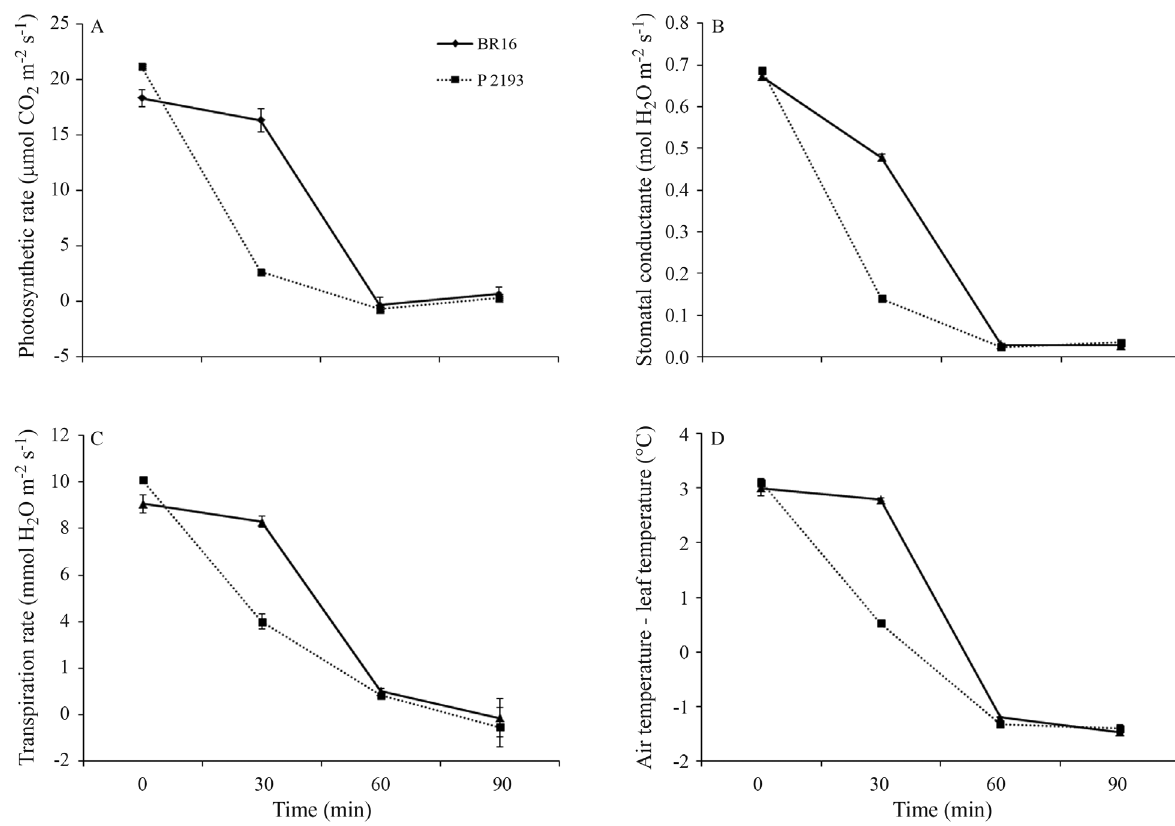
Figure 6 - Physiological responses in control plants (cultivar BR 16) and transgenic P2193 plants during stress for 30, 60 and 90 min. (A) Photosynthetic rate, (B) Stomatal conductance, (C) Transpiration rate and (D) Air-leaf temperature. The points are the mean (cid:4) SE of three determinations. The non-overlapping points at 30 min were significantly different from each other (p (cid:6) 0.05, Duncan’s